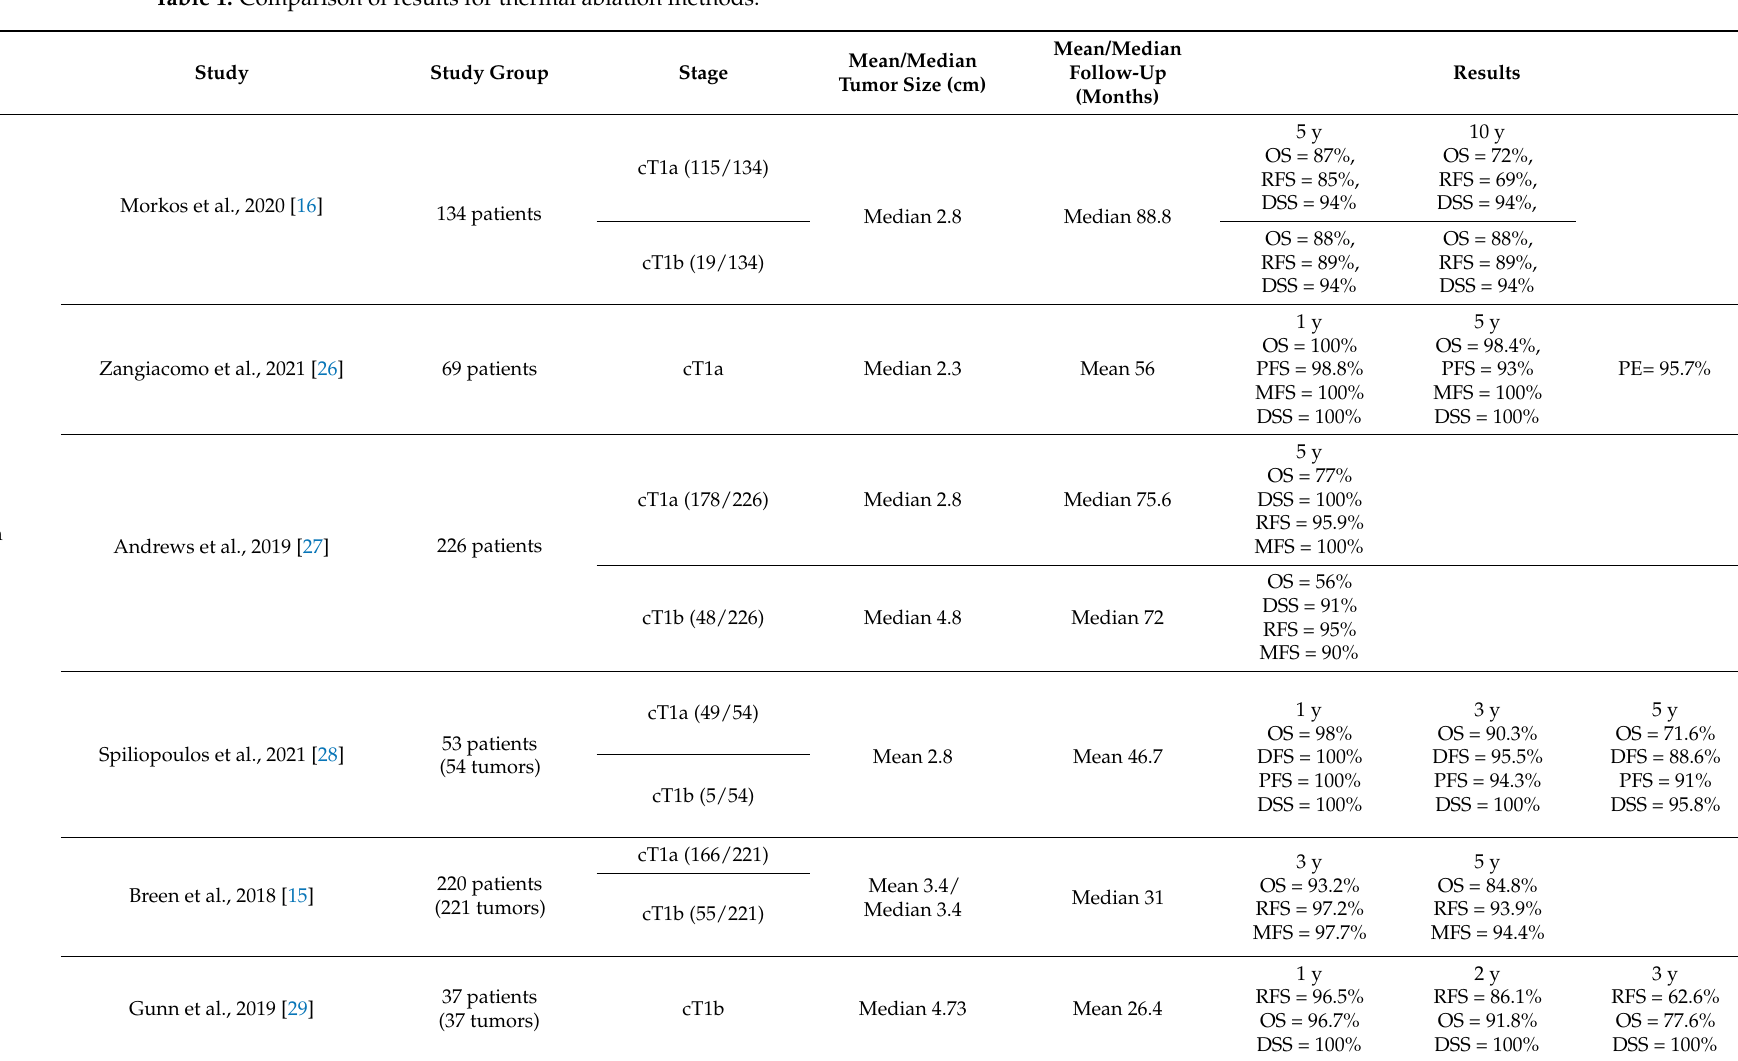
Table 1. Comparison of results for thermal ablation